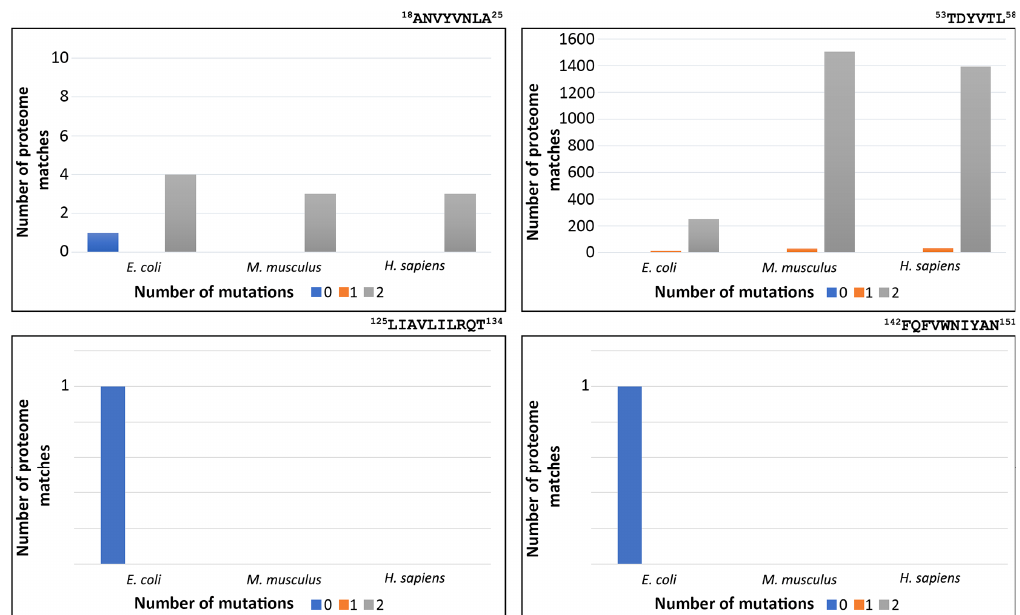
Figure 6. Number of times each FimH peptide-analogue, with zero (0), one (1), or two (2) substitutions, occurs in the proteomes of E. coli , M. musculus and H. sapiens . 18 ANVYVNLA 25 peptide-analogue’s sequence is found identical only in the E. coli proteome. Its sequence, when carrying 2 mutations, is found 4 times in E. coli and 3 times in the proteomes of M. musculus and H. sapiens , respectively. The sequence of 53 TDYVTL 58 peptide-analogue can be identified in one protein in the E. coli proteome and one protein in the M. musculus proteome. On the other hand, its sequence, when it carries one mutation, can be found in all proteomes. Specifically, it has 10 matches in E. coli proteome, 29 matches in M. musculus proteome and 33 matches in H. sapiens proteome. Additionally, when its sequence has two mutations, it displays 252, 1504 and 1394 matches in E. coli , M. musculus and H. sapiens proteomes, respectively. 125 LIAVLILRQT 134 peptide-analogue is found only in the sequence of FimH. No mutant form of it was detected in any of the proteomes. Similarly, 142 FQFVWNIYAN 151 peptide-analogue is found only in the sequence of